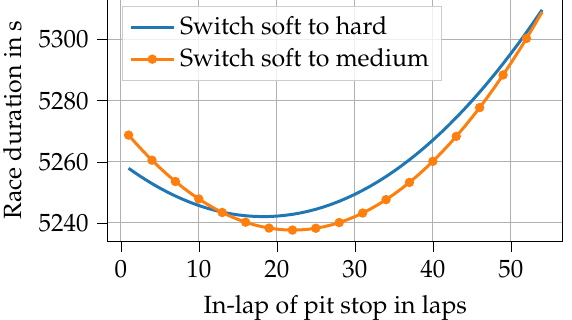
Figure 1. Race durations in an example 1-stop race in relation to the pit stop lap. Two example compound choices are shown.